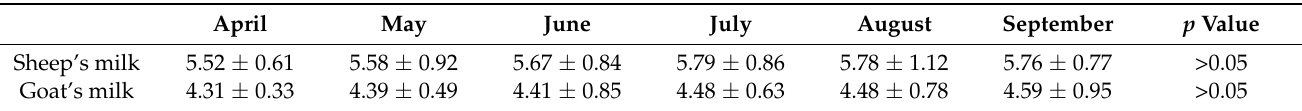
Table 3. Means and their standard deviations (mean ± SD) of log 10 SCC in sheep and goat milk samples on different months of